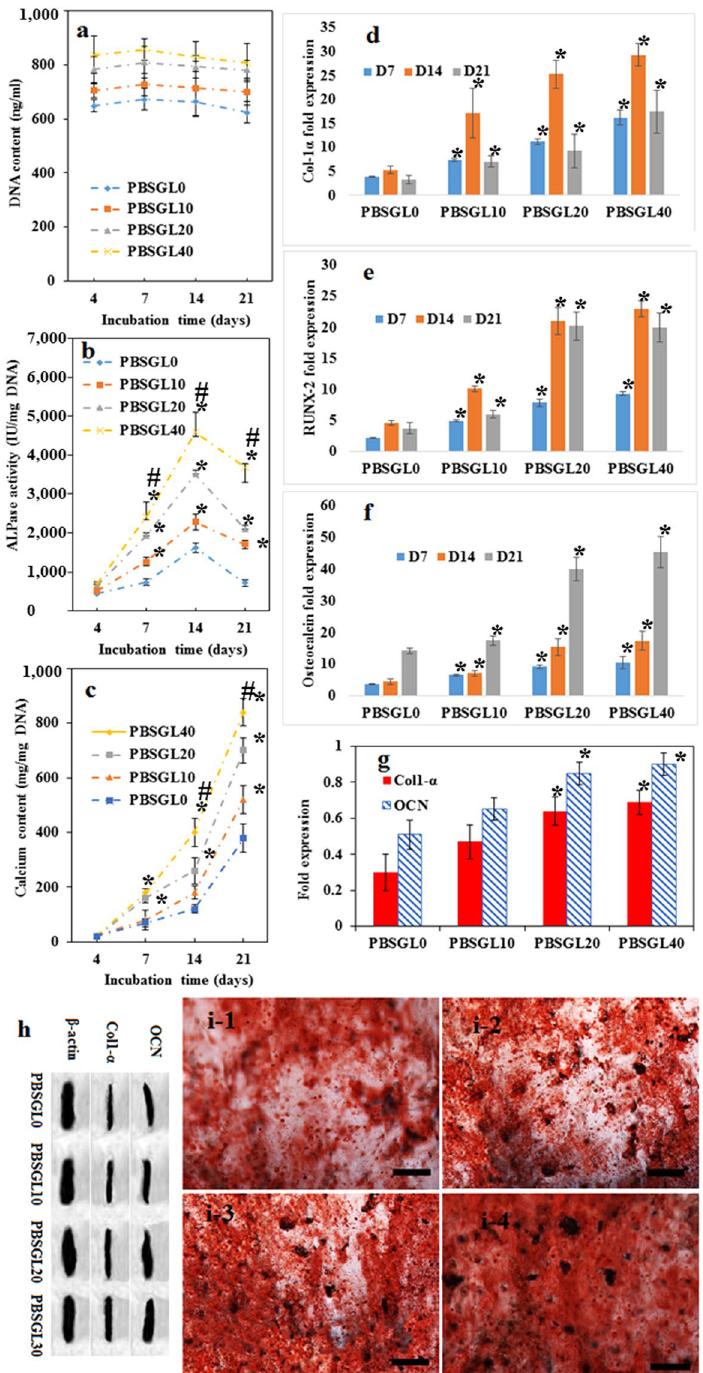
Figure 9. Osteogenic differentiation of rabbit MSCs cultured on electrospun PBSGL n membranes at days 4, 7, 14, and 21 in the osteogenic media: DNA ( a ); ALP activity ( b ); calcium content ( c ); gene expression (Col- α 1 ( d ), Runx-2 ( e ), and OCN ( f )); protein expressions of OCN and Col- α 1 at day 21 relative to β actin expression ( g ); Western blotting bands for OCN (12 kDa), Col- α 1 (130 kDa), and β actin (42 kDa) (h). Three different gels (with the same acquisition settings and exposure parameters) were used to visualize the relative protein expressions of OCN, Col- α 1 and β actin proteins. Alizarin Red staining showing deposited calcium ions on the electrospun PBSGL0 (i-1), PBSGL10, (i-2) PBSGL20, (i-3) and PBSGL40 (i-4) nanofibers at day 21. An asterisk denotes a statistically significant difference P < 0.05) between the test and control group at each time point. A “#” sign indicates a statistically significant difference between the test and all other groups at each time point. Sample size selected was